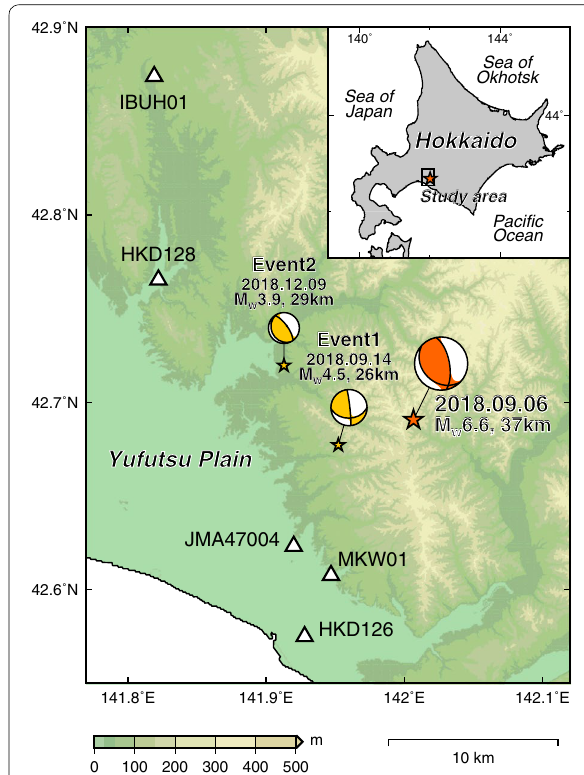
Fig. 1 Location map of the study area. The white triangles denote the station used for this study. The red and yellow stars denote the epicenters of the 2018 Hokkaido eastern Iburi earthquake and aftershocks which were determined by JMA. Hokkaido and the study area (rectangle) are shown in the top right inset